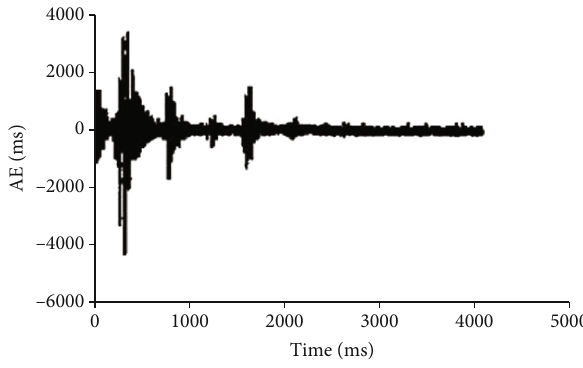
Figure 2: The typical AE wave curve.